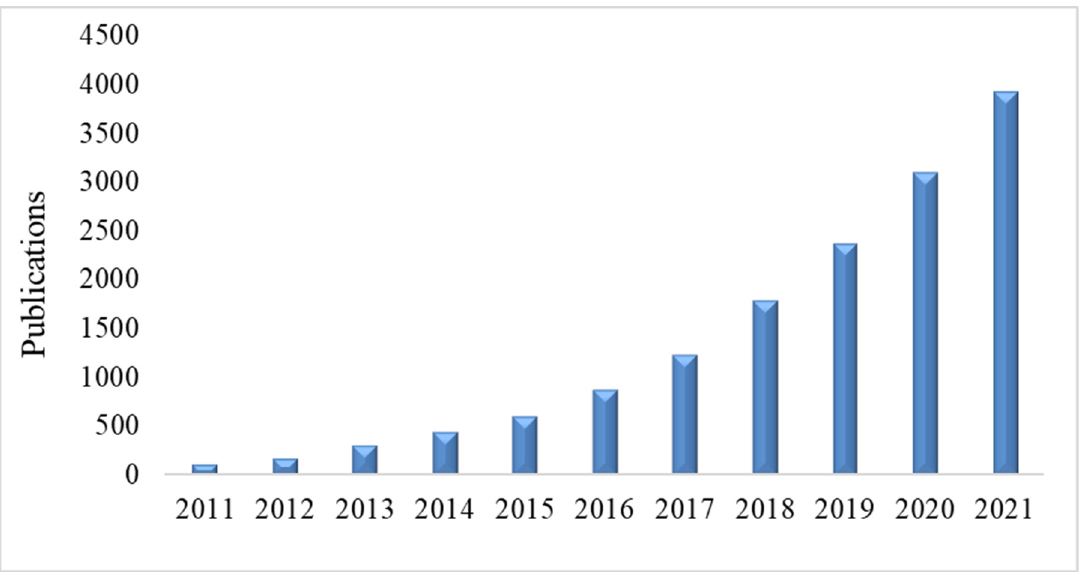
Figure 2. Total number of publications related to nanocellulose chemical sensors.